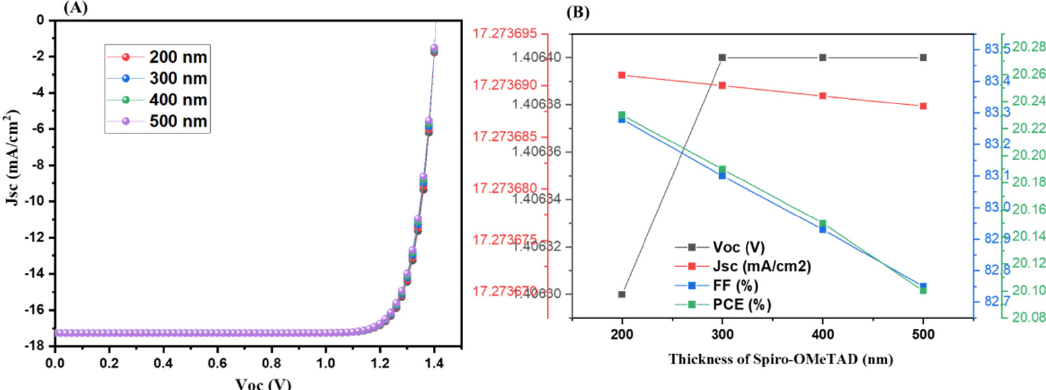
Figure 4. J-V curves ( A ) and photovoltaic parameters ( B ) of FTO/TiO 2 (50 nm)/NH 3 (CH 2 )NH 3 MnCl 4 Figure 4. J ‐ V curves (A) and photovoltaic parameters (B) of FTO/TiO 2 (50 nm)/NH 3 (CH 2 )NH 3 MnCl 4 (600 (600 nm)/Spiro ‐ OMeTAD(varying)/Au.